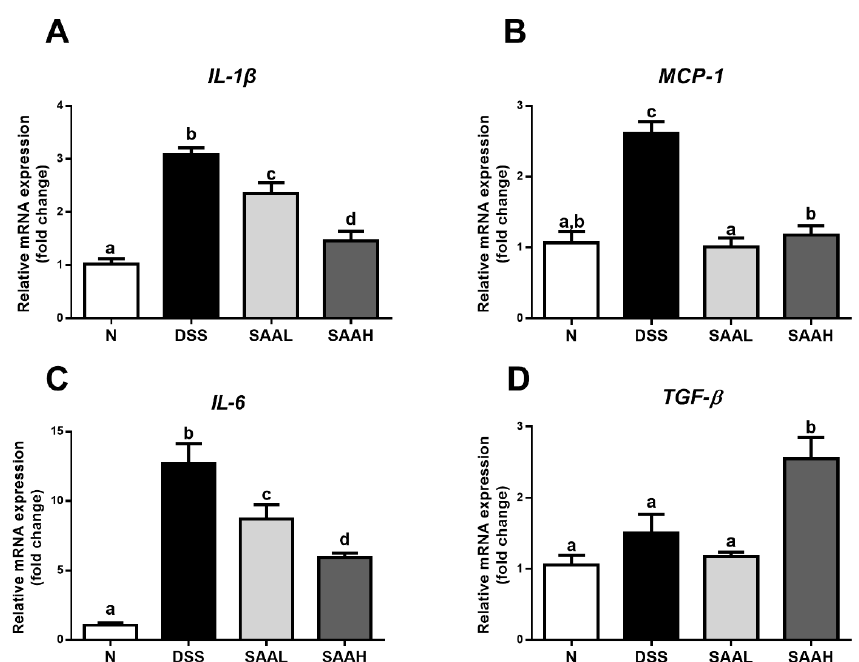
Figure 3. Effects of salvianolic acid A on inflammatory gene expression in the colonic mucosa of rats after DSS-induced colitis. The rats’ distal colons were collected, and mRNA expression of TNF- α ( A ), IL-1 β ( B ), IL-6 ( C ), and TGF- β ( D ) was quantified using real-time PCR. Fold changes are expressed as means ± SD ( n = 8 for each group in a single experiment). Groups with different letters differ by a statistically significant margin ( p < 0.05). N, normal control group; DSS, DSS colitis group; SAAL, SAA low-dosage group (SAAL, 4 mg/kg/day i.v.), and SAAH, SAA high-dosage group (SAAH, 8 mg/kg/day i.v.).